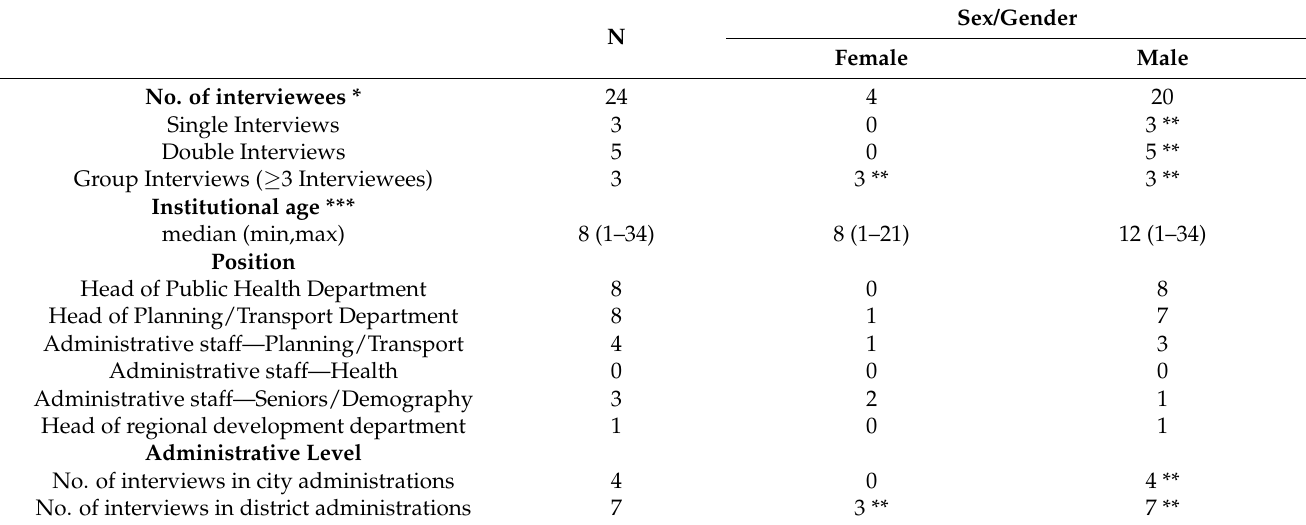
Table 1. Characteristics of interviewees.